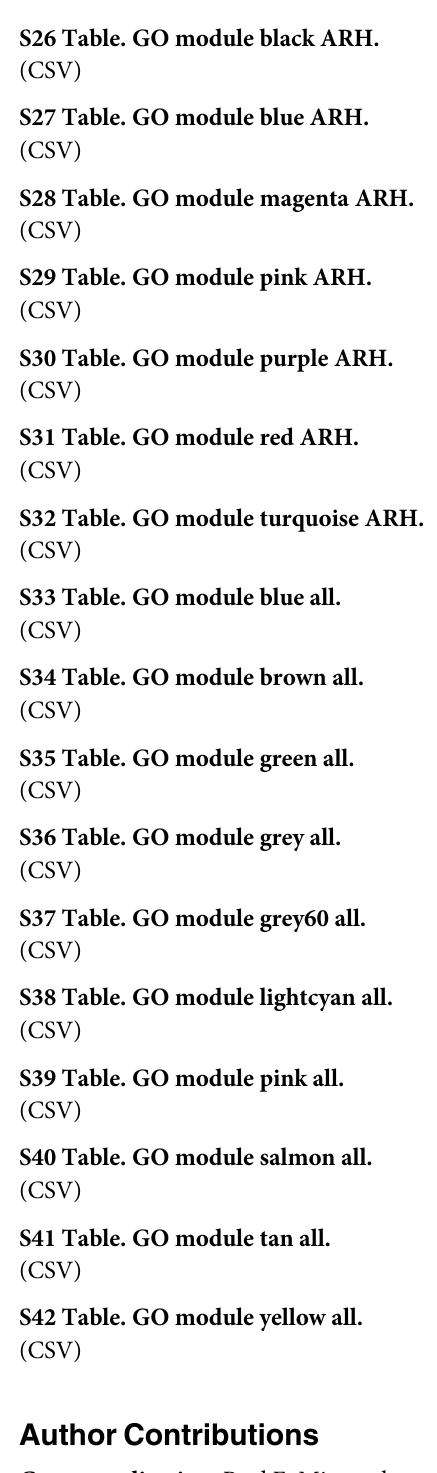
S26 Table. GO module black ARH. (CSV) S27 Table. GO module blue ARH. (CSV) S28 Table. GO module magenta ARH. (CSV) S29 Table. GO module pink ARH. (CSV) S30 Table. GO module purple ARH. (CSV) S31 Table. GO module red ARH. (CSV) S32 Table. GO module turquoise ARH. (CSV) S33 Table. GO module blue all. (CSV) S34 Table. GO module brown all. (CSV) S35 Table. GO module green all. (CSV) S36 Table. GO module grey all. (CSV) S37 Table. GO module grey60 all. (CSV) S38 Table. GO module lightcyan all. (CSV) S39 Table. GO module pink all. (CSV) S40 Table. GO module salmon all. (CSV) S41 Table. GO module tan all. (CSV) S42 Table. GO module yellow all.